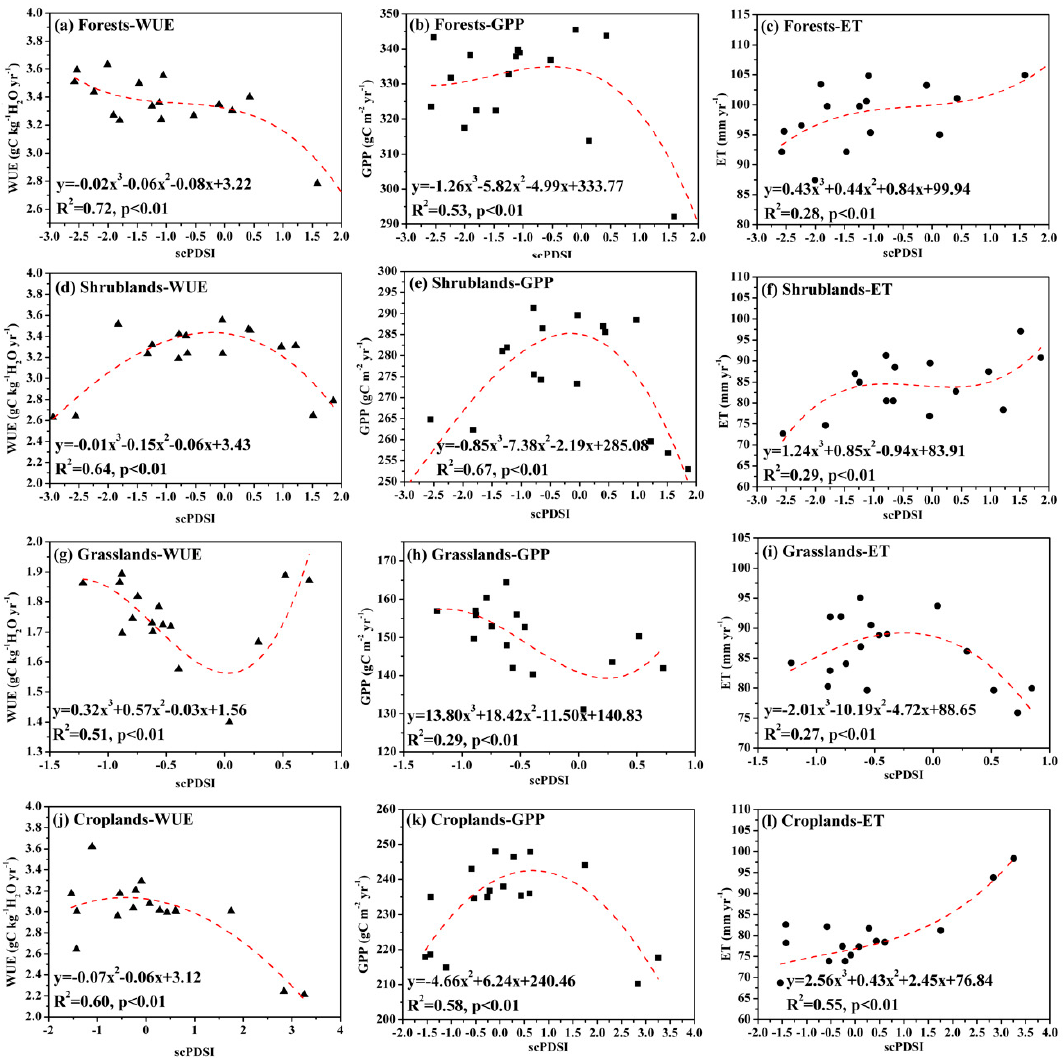
Figure 11. Variations of annual WUE, GPP, and ET with changing wet or dry conditions (scPDSI) over the period 2000–2017 for forests ( a – c ), shrublands ( d – f ), grasslands ( g – i ), and croplands ( j – l ).